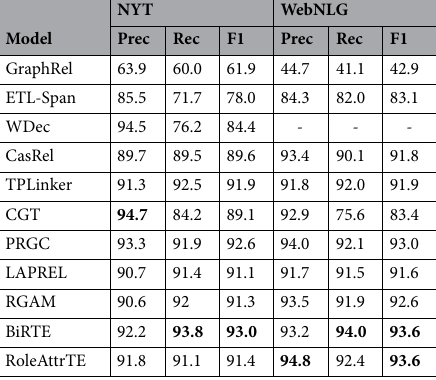
Table 3. Main results, where the bolded marks are the highest scores, and the baseline result data comes from the original literature.